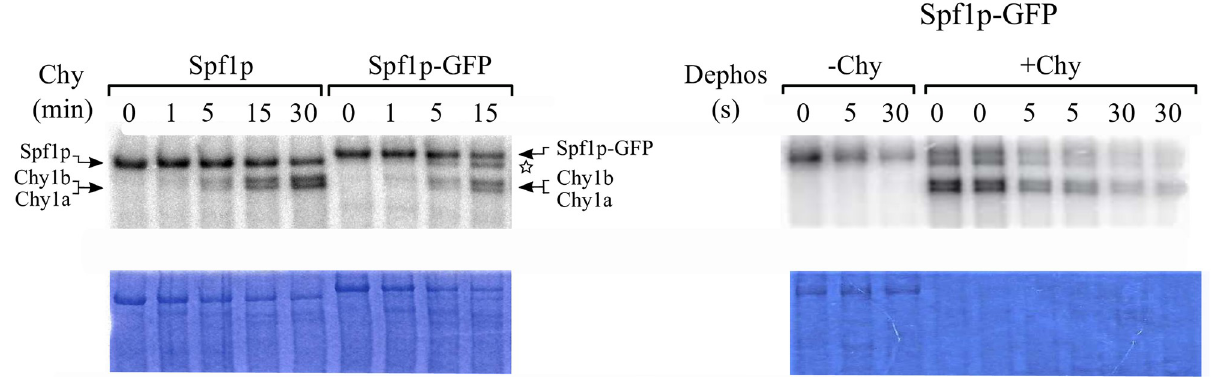
Fig 7. Formation and decomposition of the catalytic phosphoenzyme by the chymotrypsin treated Spf1p and Spf1p-GFP. The Spf1p and Spf1p- GFP proteins were digested with chymotrypsin at a (w/w) ratio of 30:1 protein to chymotrypsin. After the time indicated on top of each lane the proteolysis was stopped by adding 2.5 μ g of aprotinin and cooling to 4˚C. The phosphorylation reaction (left panel ) was started by the addition of 0 . 5 μM [ γ 32 P]-ATP and terminated after 30 s by the addition of TCA. For dephosphorylation ( Dephos , right panel ) digested samples were phosphorylated for 60 s with 0 . 5 μM [ γ 32 P]-ATP and the dephosphorylation reaction started by the addition of 0.5 mM ATP. After the times indicated on top the reaction was stopped by the addition of TCA. The samples were electrophoresed in an acidic 7.5% SDS-PAGE and revealed by Colloidal Coomassie staining ( bottom panels ) and radioactivity ( top panels ). The migration of the Spf1p-GFP proteolytic product probably generated by the cleavage at the C-terminus of Spf1p is indicated with a star symbol ( ☆